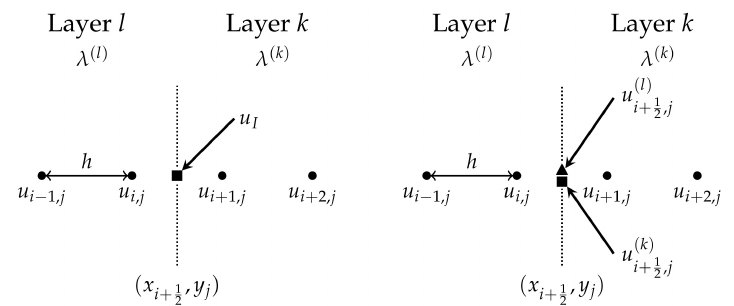
Figure 3. Schematic sketch at the interface x i = ( x , y j ) between layers k and l using the proposed i + 1 2 finite difference scheme at grid points (dots) and equidistant mesh size h . Left: Discretisation of the interaction between different types of soils leads to fulfilling the matching conditions (3) and (4) around the fictitious interface point, and defining the value u I using the Formula (14). Right: Discretisation of the interaction between soil and insulation leads to fulfilling the matching conditions (3) and (5) around the fictitious interface points, and defining left and right values u ( k ) and u ( l ) i + 1 2 , j i + 1 2 , j using the system of linear Equation